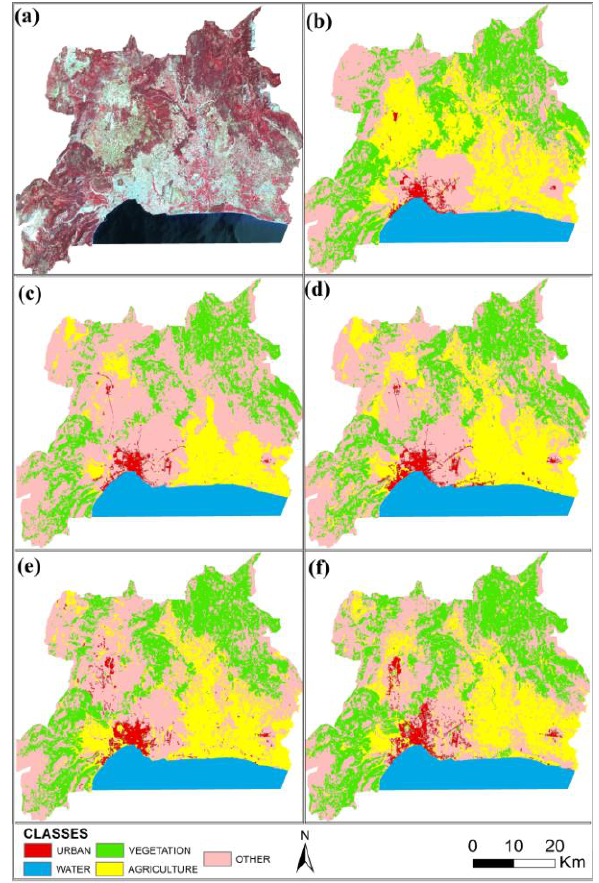
Figure 3. The false color composite of 2015 Landsat image of the study area in (a) and LULC maps; (b) 1995, (c) 2000, (d) 2005, (e) 2010 and (f)